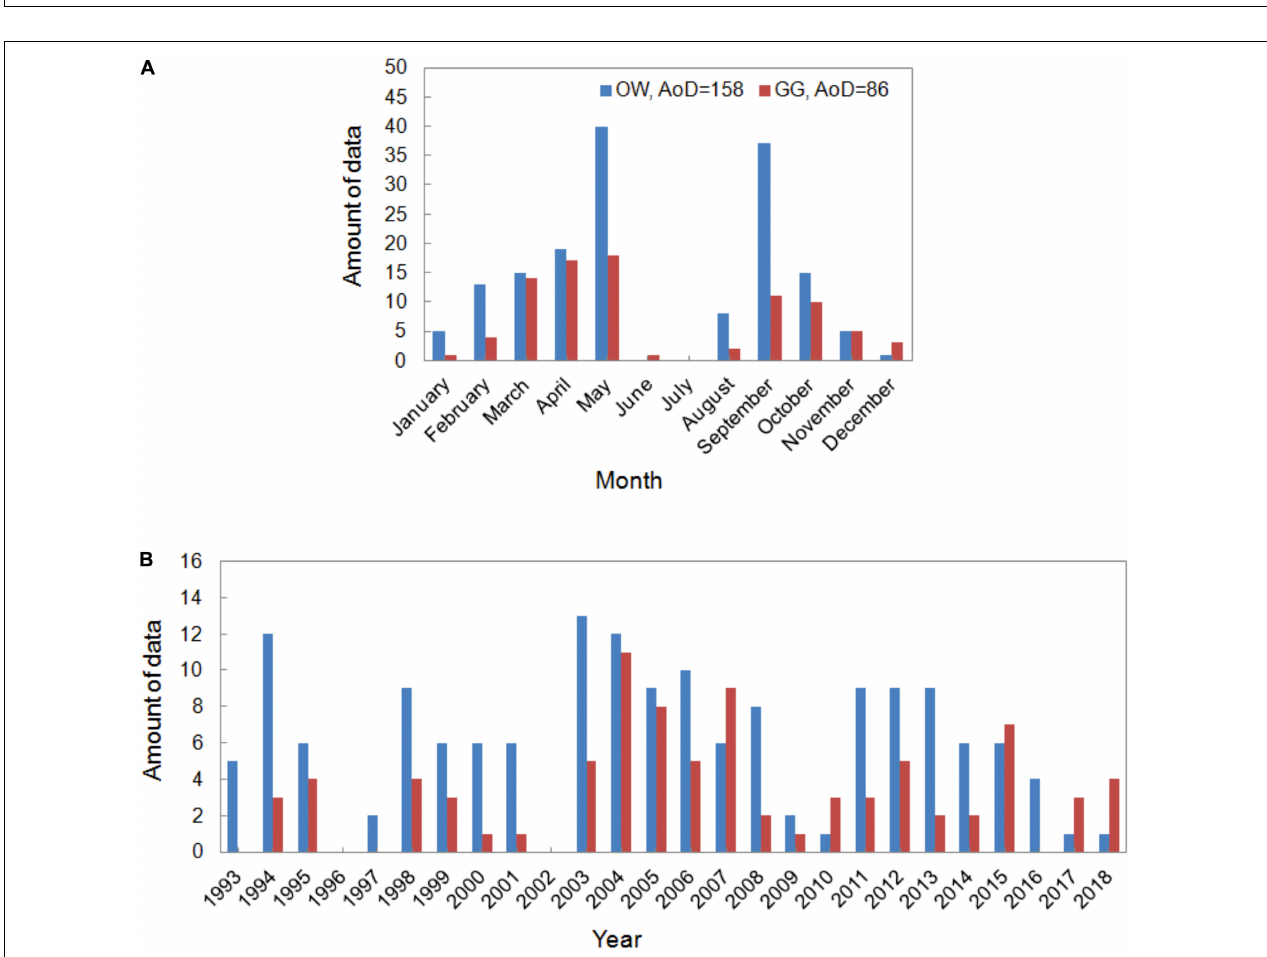
Frontiers in Marine Science |